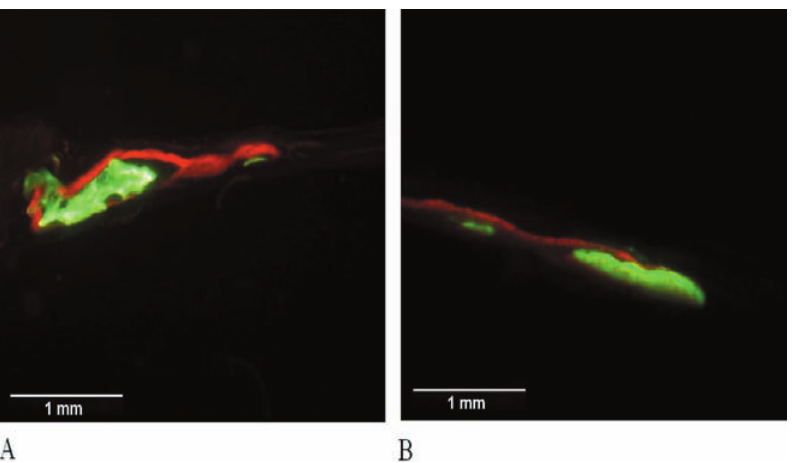
Figure 9- Fluorochrome-labeled areas in the Control Group. Three of five animals did not show labeled areas (green = calcein ; red = alizarin)